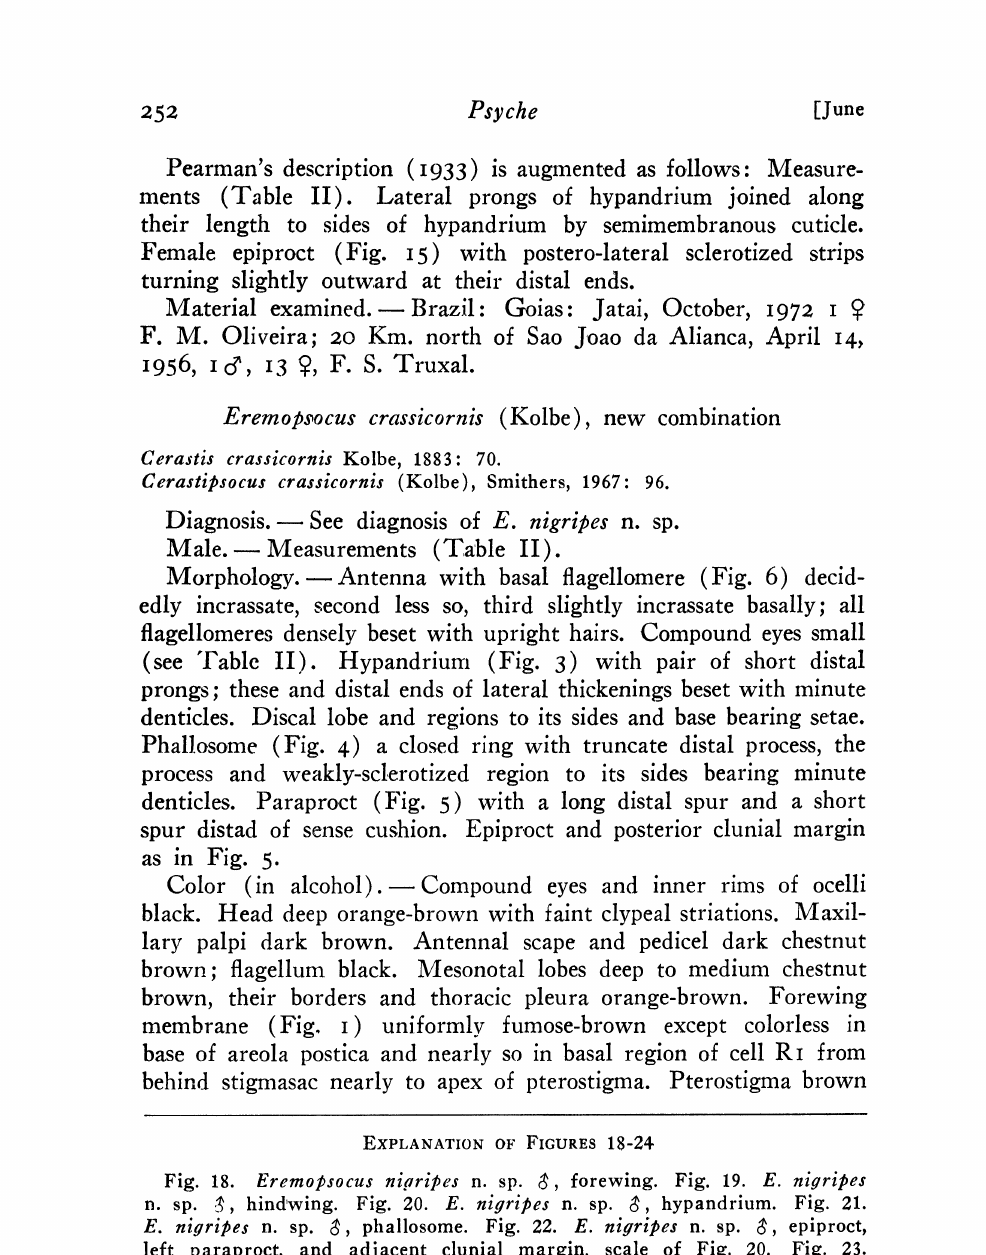
Fig. 18. Eremopsocus ni.aripes n. sp. 6, forewing. Fig. 19. E. nieripes n. sp. $, hind’wing. Fig. 20. E. nigripes n. sp. 6, hypandrium. Fig. 21. E. nigripes n. sp. 6, phallosome. Fig. 22. E. nitTripes n. sp. 6, epiproct, left paraproct, and adjacent clunial margin, scale of Fig. 20. Fig. 23. E. niTripes n. sp. 6, antenna (scape through base of f3), scale of Fig. 18. Fig. 24. E. nieripes n. sp. 9, antenna (scape through base of f,), scale of Fig.